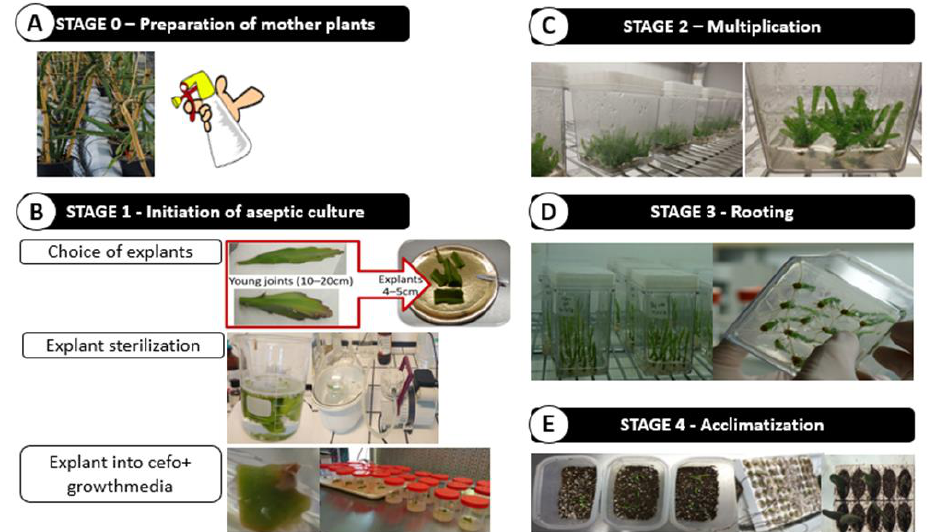
Figure 6. A schematic representation of pitaya in vitro propagation procedure. Preparation of mother plants, stage 0 ( A ); Initiation of aseptic culture, stage 1 ( B ); Multiplication, stage 2 ( C ); Rooting, stage 3 ( D ); Acclimatization, stage 4 ( E ).